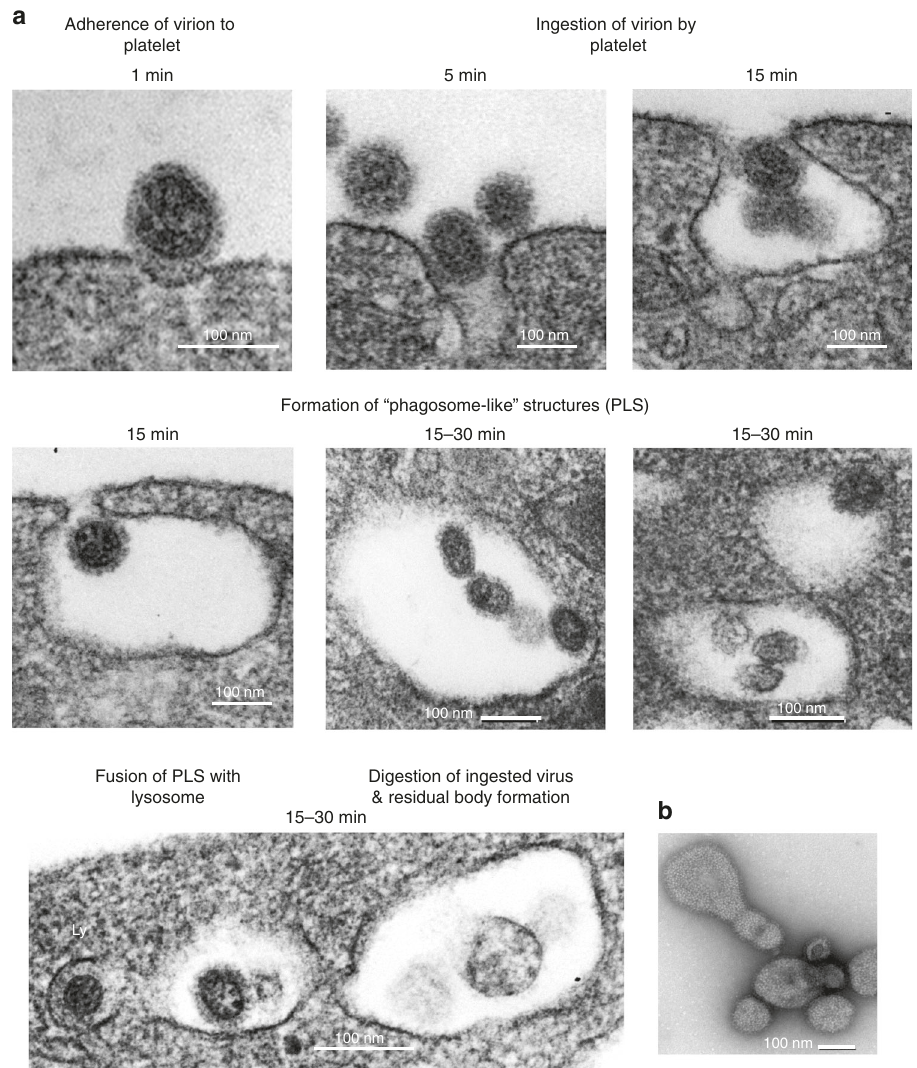
Fig. 4 Stages of phagocytosis in platelets ’ internalization of in fl uenza. Phagocytic morphological features of in fl uenza internalization by platelets was assessed by TEM. a Representative images of different stages of phagosome-like structures assessed by morphological features captured in platelets from healthy human donors incubated with WSN/33 in fl uenza (1 pfu to 10 platelets) at different time points. Five distinct stages can be observed in human platelets. b TEM of the negative stain of in fl uenza virus